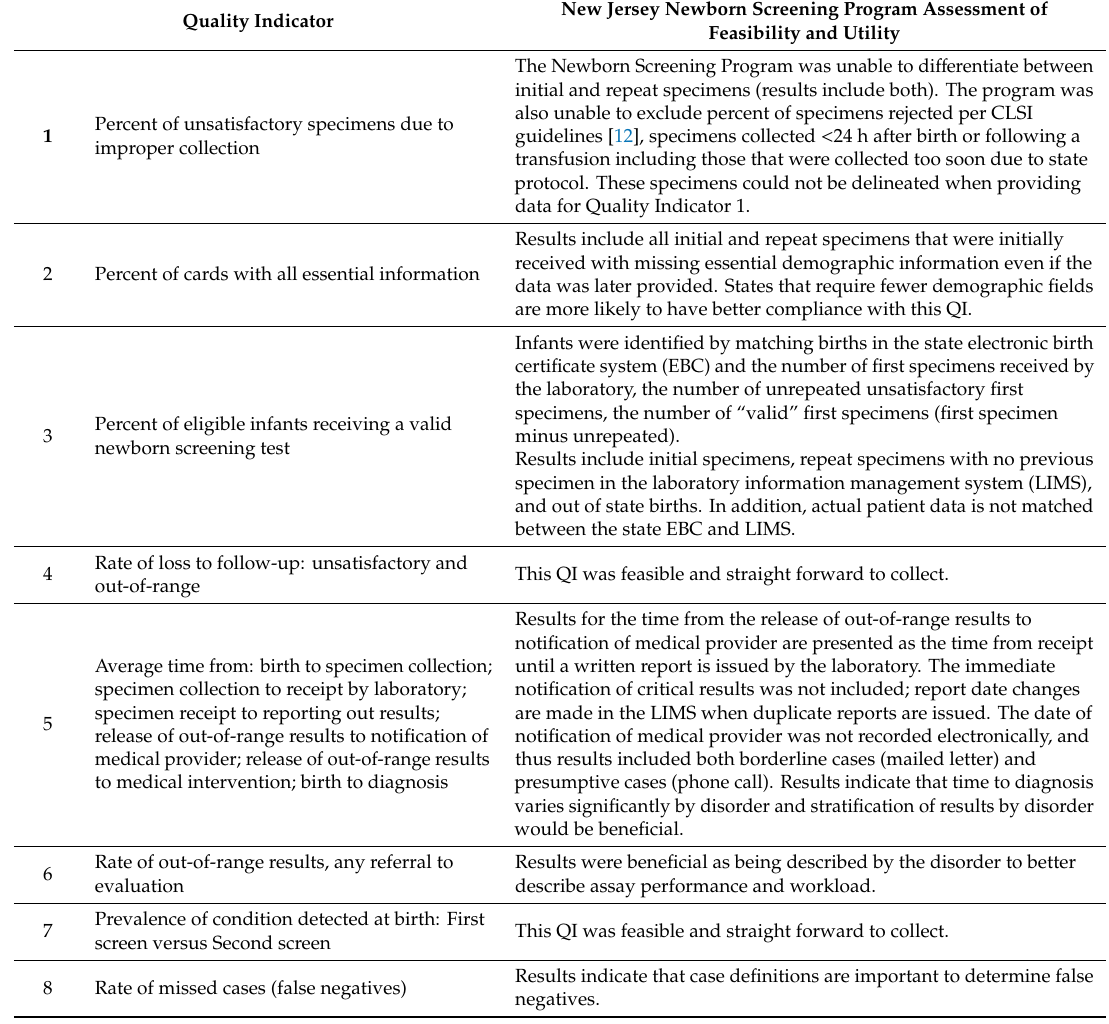
Table 3. New Jersey Newborn Screening Program quality indicator pilot study